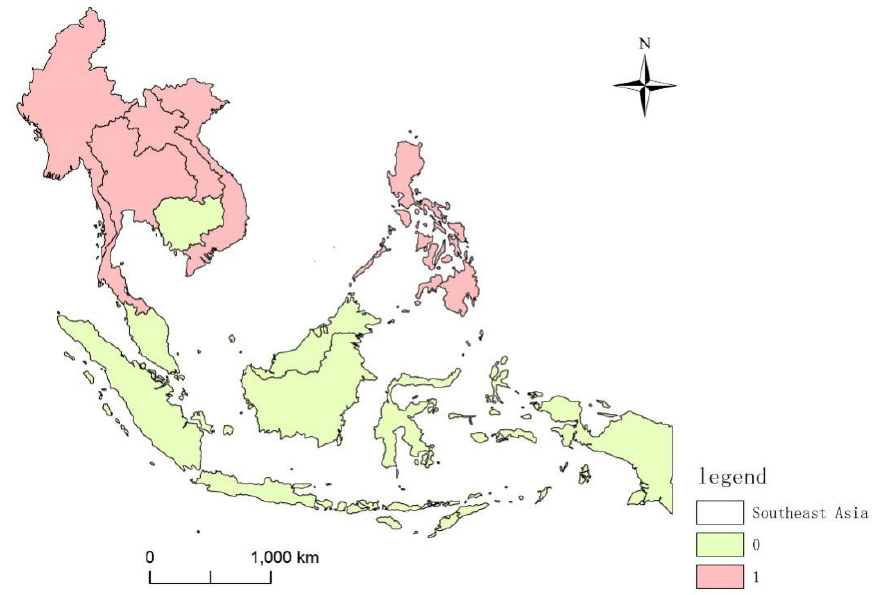
Figure 7. Partition results.